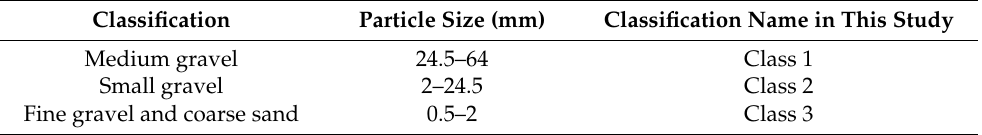
Table 1. Classification criteria in this